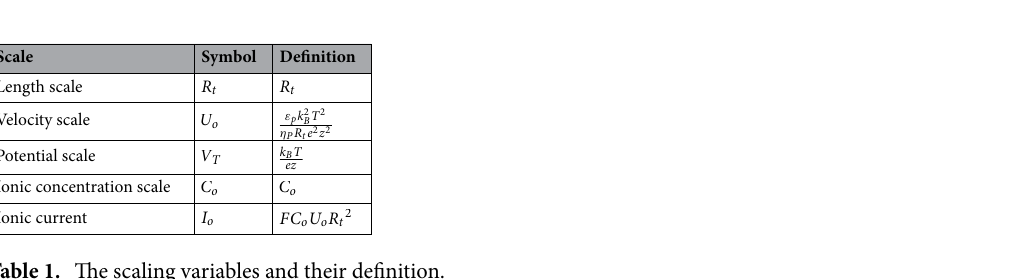
Table 1. The scaling variables and their